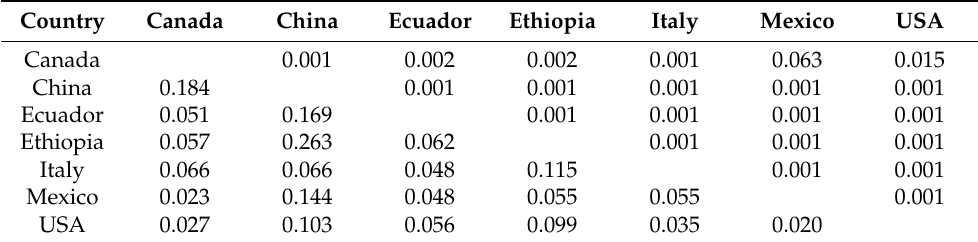
Table 5. Pairwise comparison of populations of Puccinia striiformis f. sp. tritici from seven countries based on the fixation index (F ST ) values a